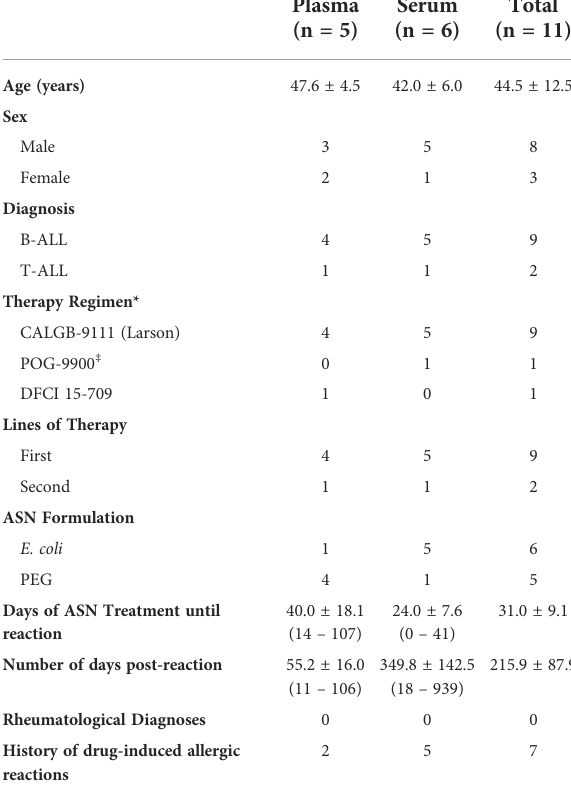
TABLE 2 Summary of patient descriptors for samples with detectable anti-asparaginase IgG